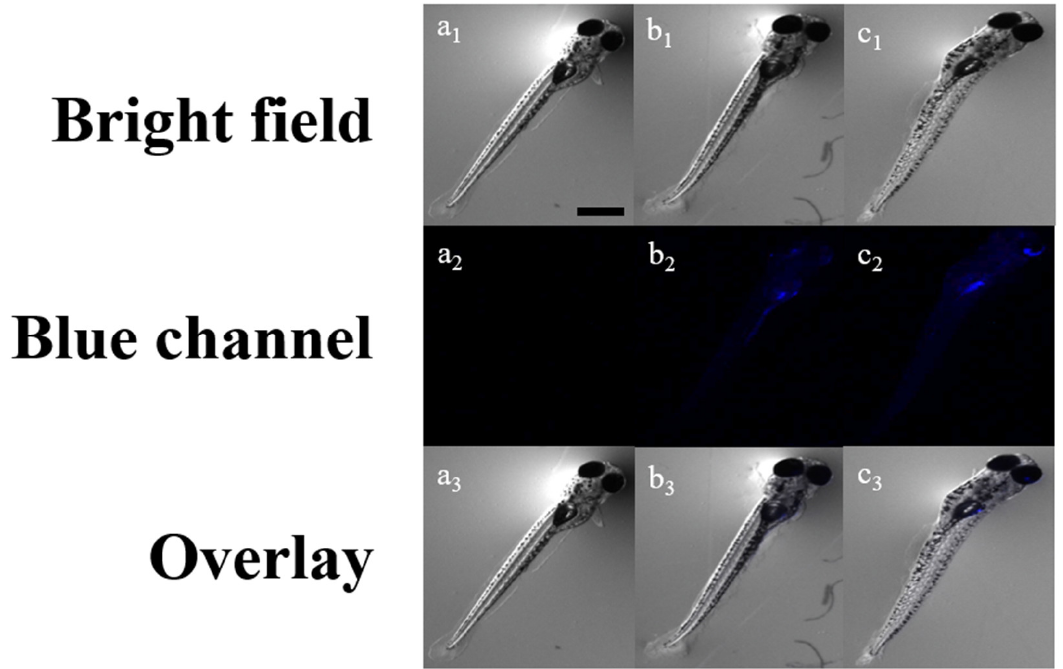
Figure 3. Fluorescent images of zebrafish cultured with IH-Sal followed by addition of Zn 2+ . ( a 1 – a 3 ): IH-Sal only; ( b 1 – b 3 ): IH-Sal with 2.5 × 10 −5 M Zn 2+ ; ( c 1 – c 3 ): IH-Sal with 5 × 10 −5 M Zn 2+ . [ IH-Sal ] = 2.0 × 10 −5 M. Scale bar: 0.91 mm.